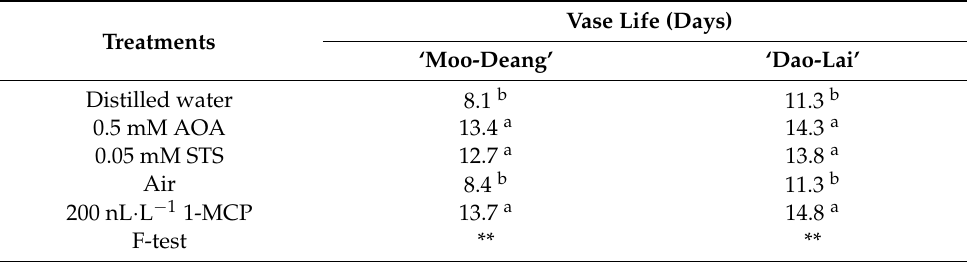
Table 3. Effect of inhibitors of ethylene biosynthesis or perception on vase life duration of cut inflorescences of ‘Moo-deang’ and ‘Dao-lai’ Mokara orchid hybrids. Application of treatments was as detailed in Figure 5. Following treatments, the inflorescences were transferred to distilled water, and incubated in the observation room. The results represent means of 8–10 replicates ± SE. Different letters and ** represent significant differences at p ≤ 0.01 compared to distilled water or air controls according to DMRT test.